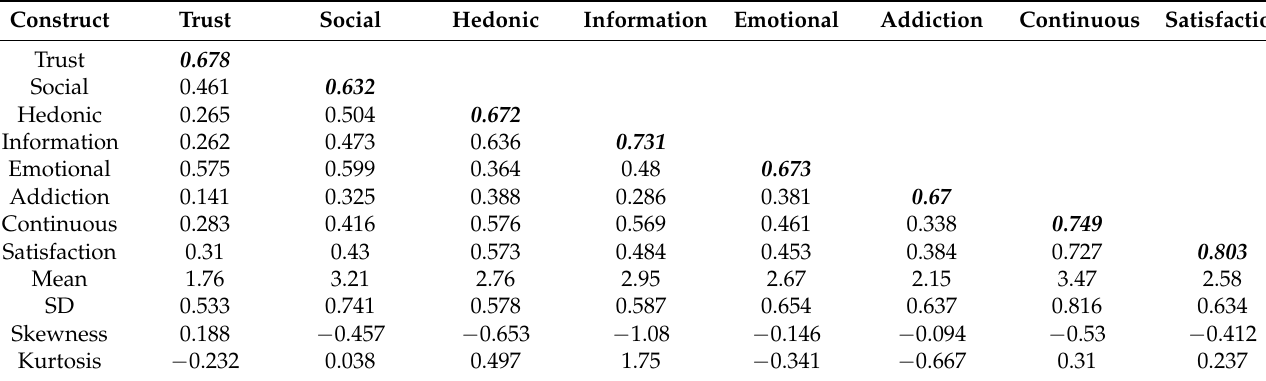
Table 7. Descriptive statistics and correlations